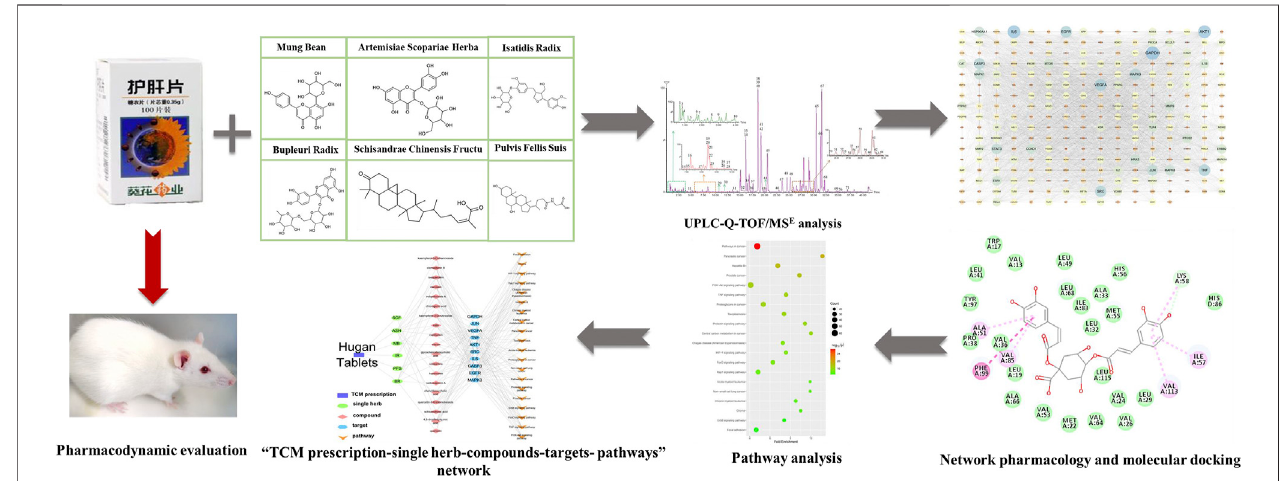
FIGURE 1 | Flowchart for the investigation of the mechanism of Hugan tablets in treating drug-induced liver injury induced by atorvastatin.